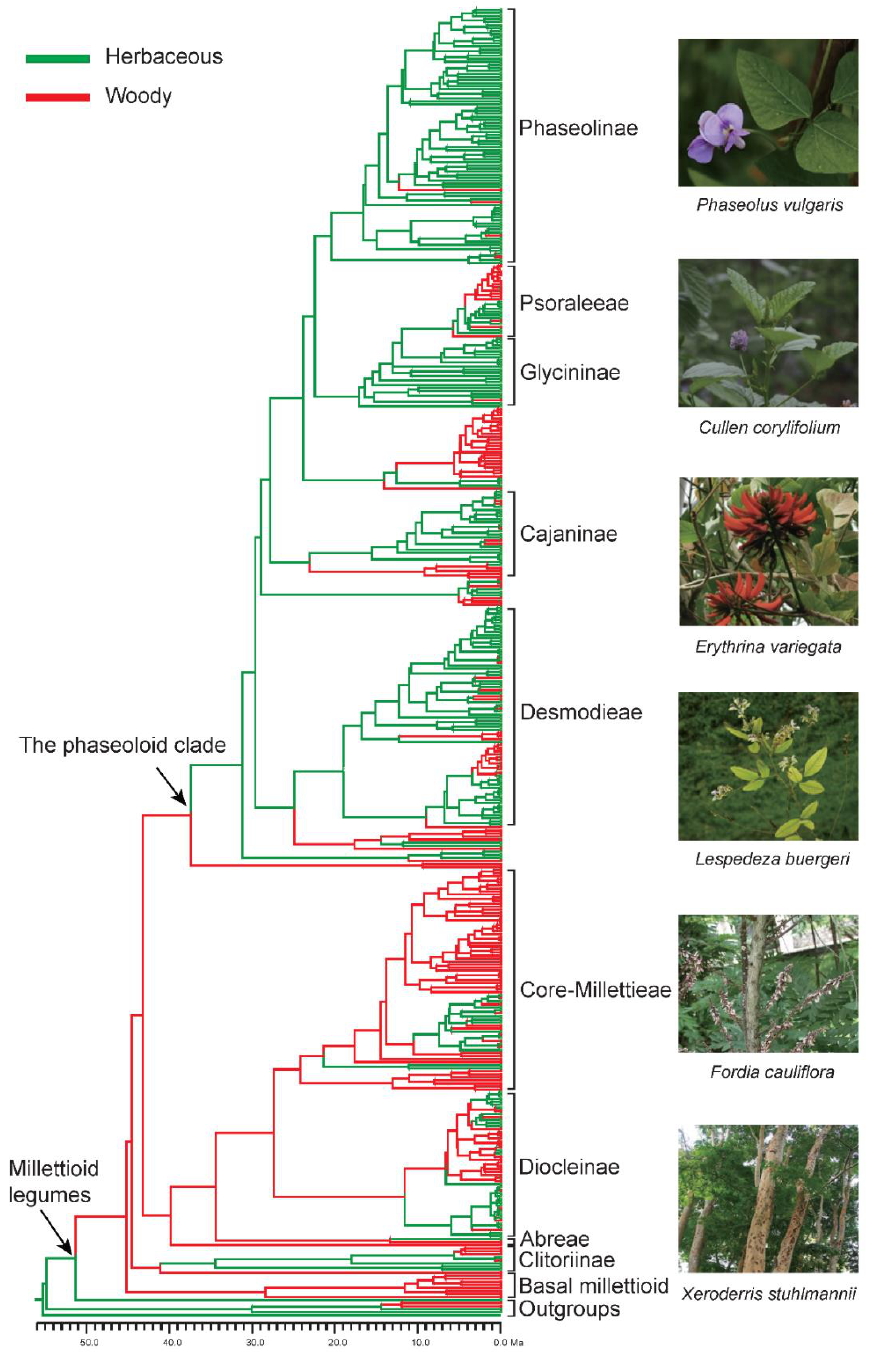
Figure 2. Habit shift analysis of the Millettiod legumes. Green represents herbaceous; red represents woody. Images are representative species from the Millettiod legumes.